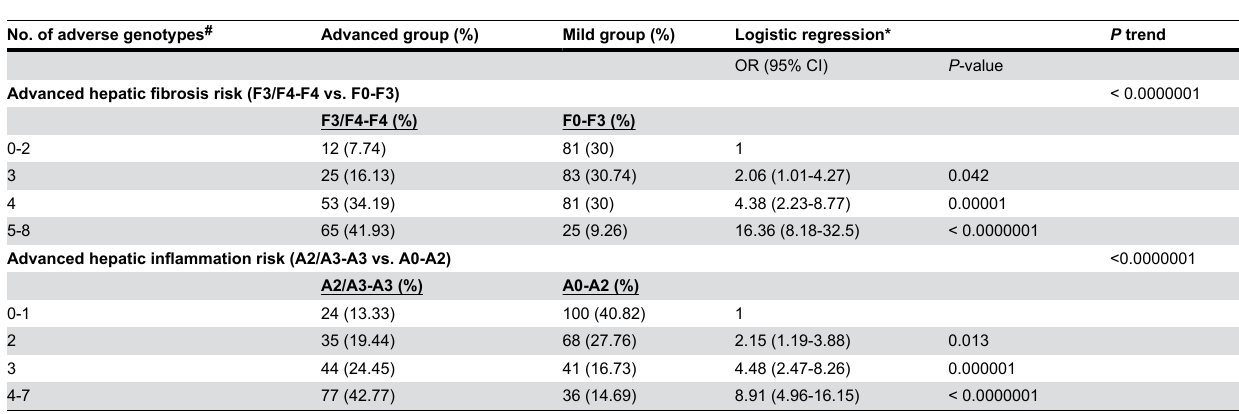
Table 3. Cumulative genetic risk analysis of adverse genotypes on advanced hepatic fibrosis or inflammation risk in patients with